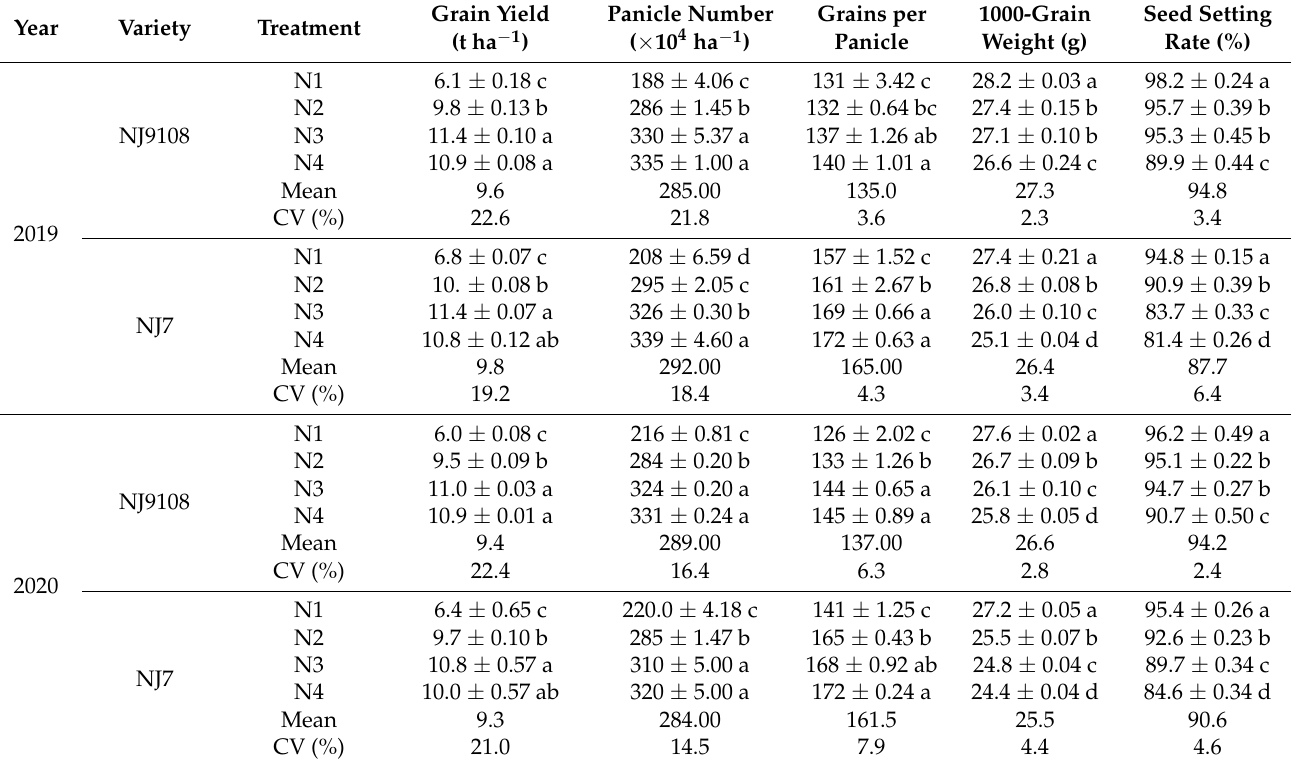
Table 1. Effect of nitrogen fertilizer level on grain yield and its